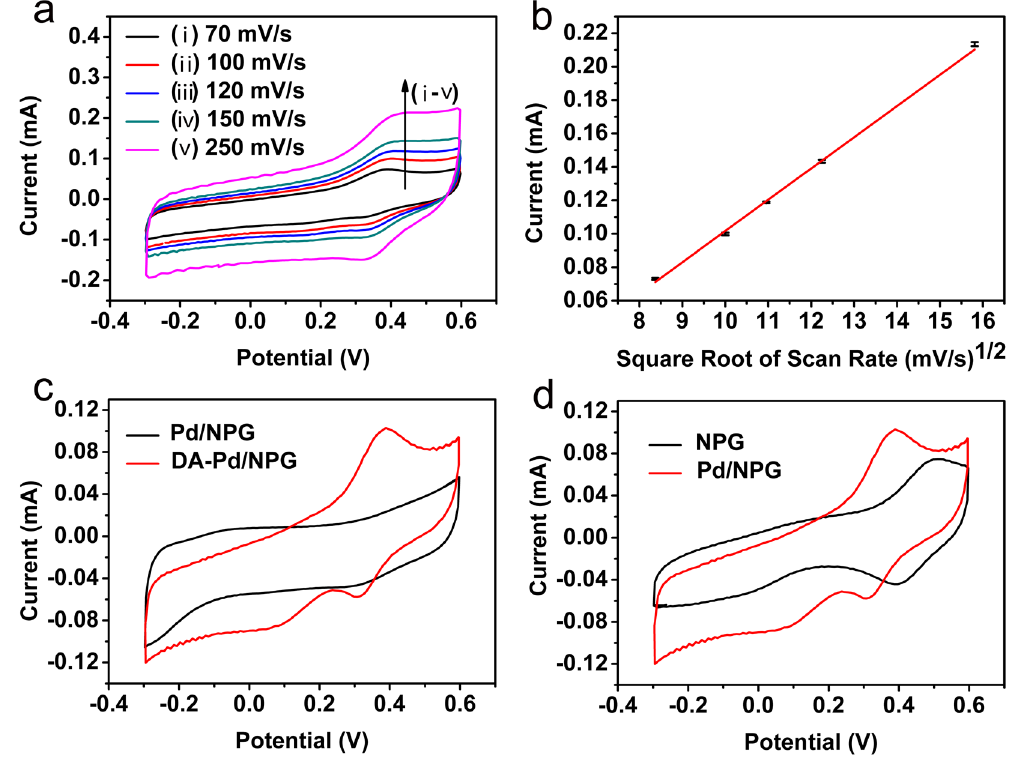
Figure 3. Electrochemical characterazations of the Pd/NPG wire biosensor. ( a ) The CV curves of the Pd/NPG wire biosensor at various scan rates (from (i) to (v): 70, 100, 120, 150 and 250 mV/s). ( b ) The calibration plot of the oxidation peak current of DA versus the square root of scan rate (70–250 mV/s). ( c ) The CV curves of Pd/NPG wire biosensor in the PBS containing 0 μ M and 100 μΜ DA at the scan rate of 100 mV/s. ( d ) The CV curves of NPG wire biosensor and Pd/NPG wire biosensor in the PBS containing 100 μ M DA at the scan rate of 100